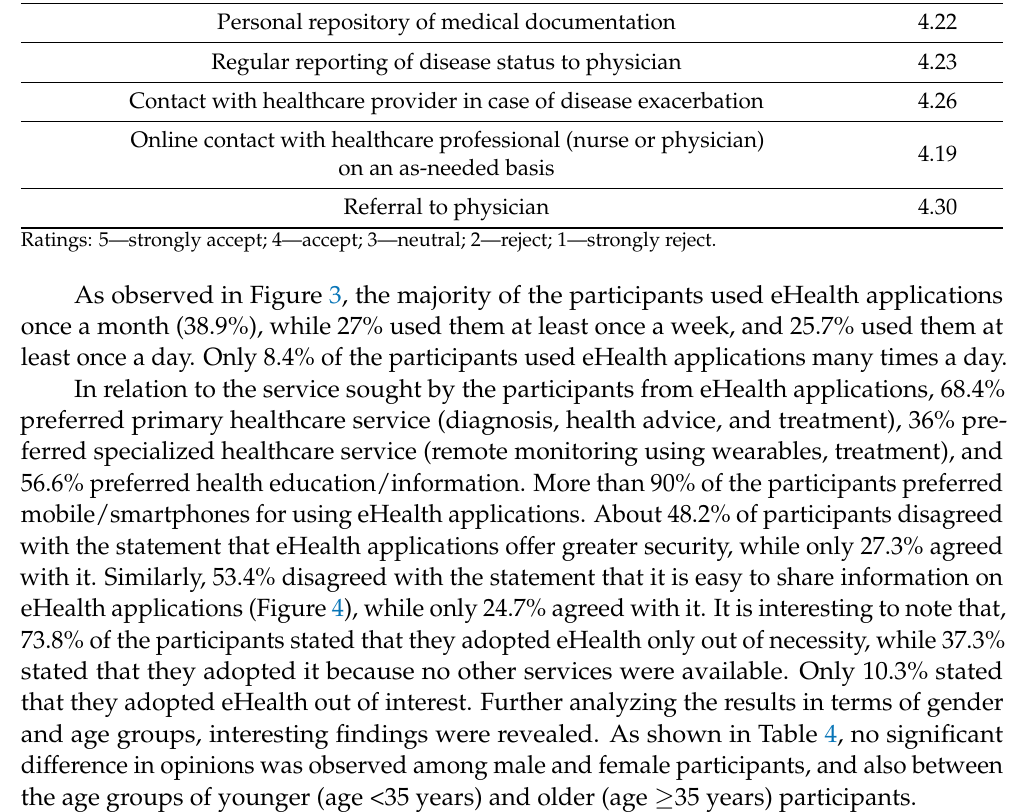
Table 3. Participants ’ levels of acceptance for using the following activities on eHealth applica- tions.